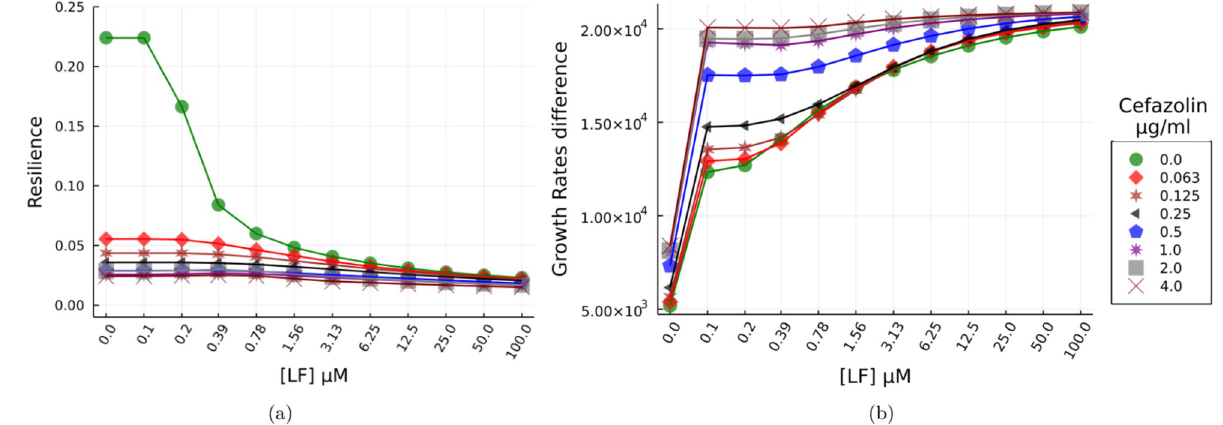
Fig 5. Resilience and differential growth rates of the bacterial population as a function of native lactoferrin/ β -lactam concentrations. a) Average resilience data from a stochastic ( N = 10000) simulation for 8 different doses of Cefazolin, 12 different doses of native lactoferrin, and with different initial susceptible and persister cell fractions are plotted. The variability in the initial population leads to non-unitary value for no treatment condition. b) Difference in maximum growth rates between susceptible (fast growing) and persister (slow growing) cells as function of native lactoferrin/ β - lactam concentrations. Values are the average difference between the maximum growth rates for these populations from a stochastic ( N = 10000) simulation with different initial susceptible and persister cell fractions.